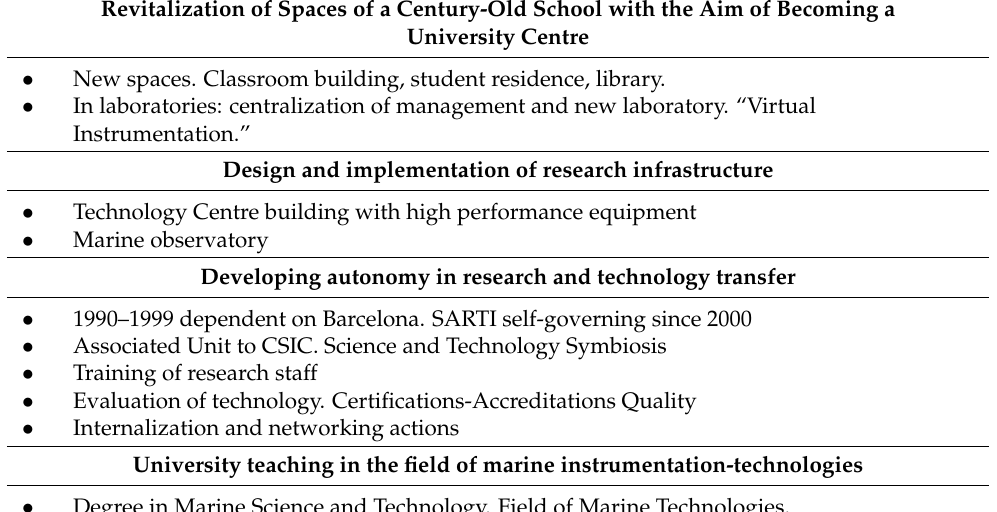
Table 15. Brief summary of